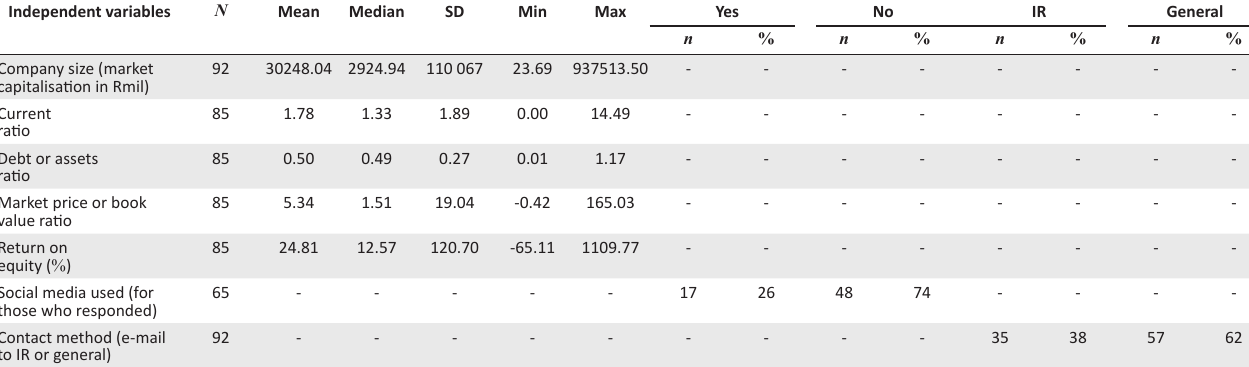
TABLE 4: Descriptive statistics of the independent variables. Independent